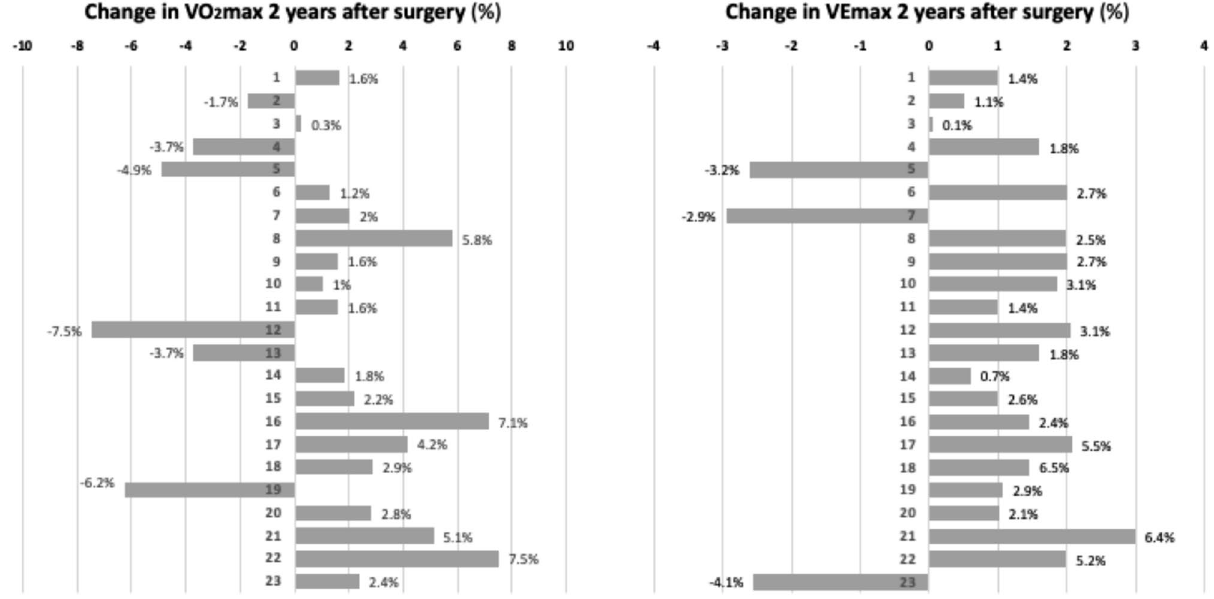
Figure 2. Changes in VO2max (ml/min/kg) and VE (L/min) after surgical correction of the hyperkyphosis as compared to preoperative